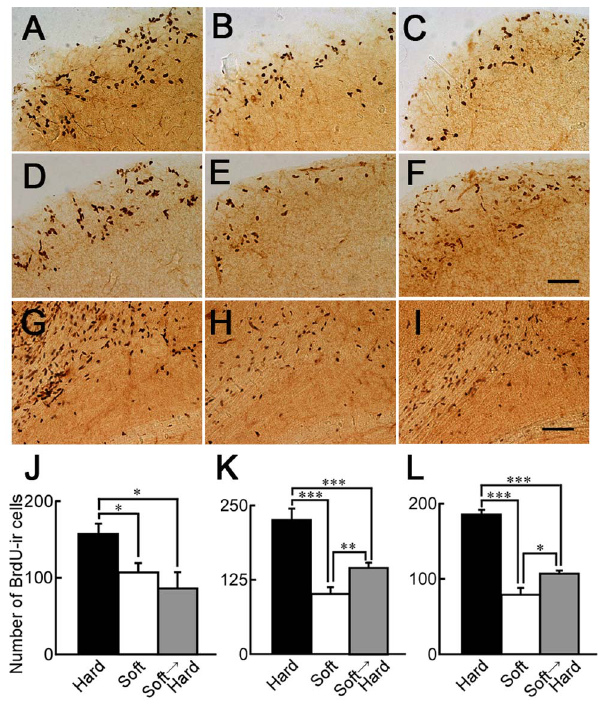
Figure 4. BrdU-ir cells in the SVZ of mice fed a hard diet for 1 or 3 months after being fed a soft diet. Sagittal sections of the SVZ of mice fed only a hard diet (A and D), only a soft diet (B and E), or a hard diet for 1 (C) or 3 months (F) after a soft diet for 1 month. Sagittal sections of the OB of mice fed only a hard diet (G), only a soft diet (H), and a hard diet for 3 months after a soft diet for 1 month (I). Scale bar: 200 m m (F and I); J and K: The numbers of BrdU-ir cells in 600 m m thickness from Figure 108 of the mouse atlas (lateral 0.84 mm) of the SVZ to the lateral side of mice fed only the hard diet (black column), only the soft diet (white column), or the hard diet for 1 month (J) or 3 months (K) after the soft diet (gray column). n=4 without white column in K, n=5 for white column in K. L: The number of BrdU-ir cells in 300 m m thickness from Figure 108 of the mouse atlas (lateral 0.84 mm) of the OB to the lateral side of mice fed only the hard diet (black column; n=4), only the soft diet (white column; n=5), or the hard diet for 3 months after the soft diet for 1 month (gray column; n=4). *: p , 0.05; **: p , 0.01; ***: p , 0.0001.